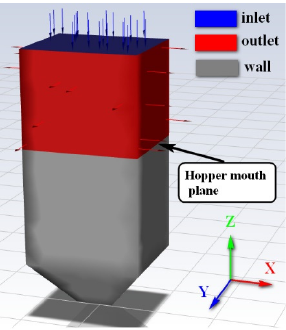
Figure 3. Three-dimensional model of the fluid domain. Table 1. DEM parameters used in simulations.